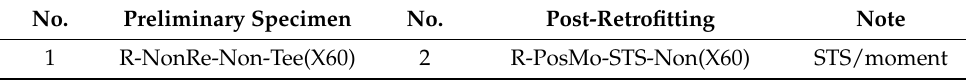
Table 3. Comparable specimens in preliminary and post-retrofitting tests.